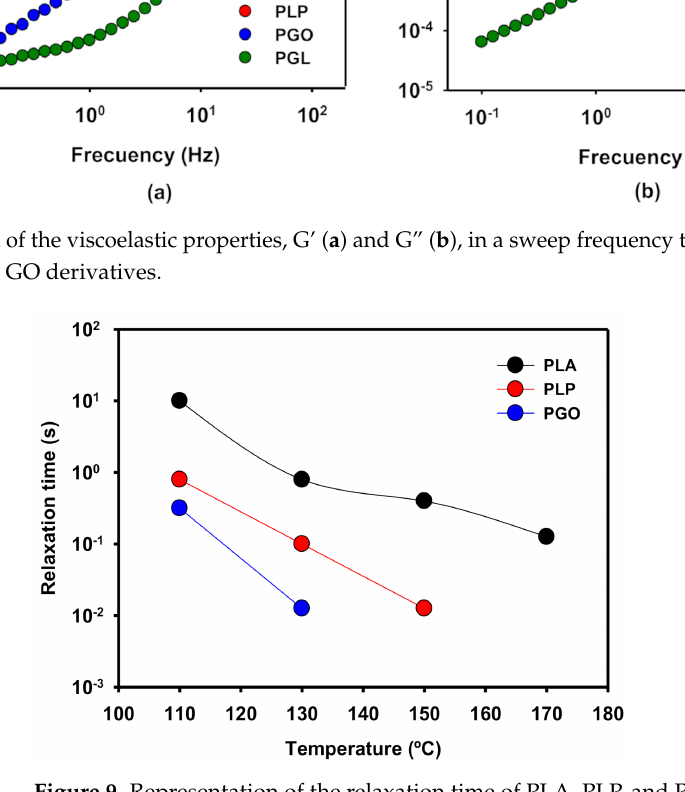
Figure 9. Representation of the relaxation time of PLA, PLP, and PGO at different temperatures.